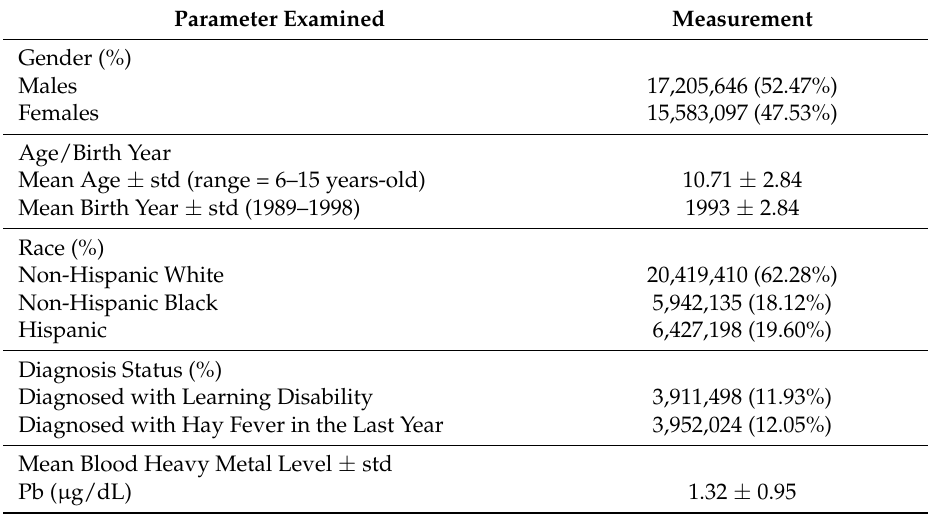
Table 1. A summary of the composition of weighted persons (n = 32,788,743) examined in this study. Parameter